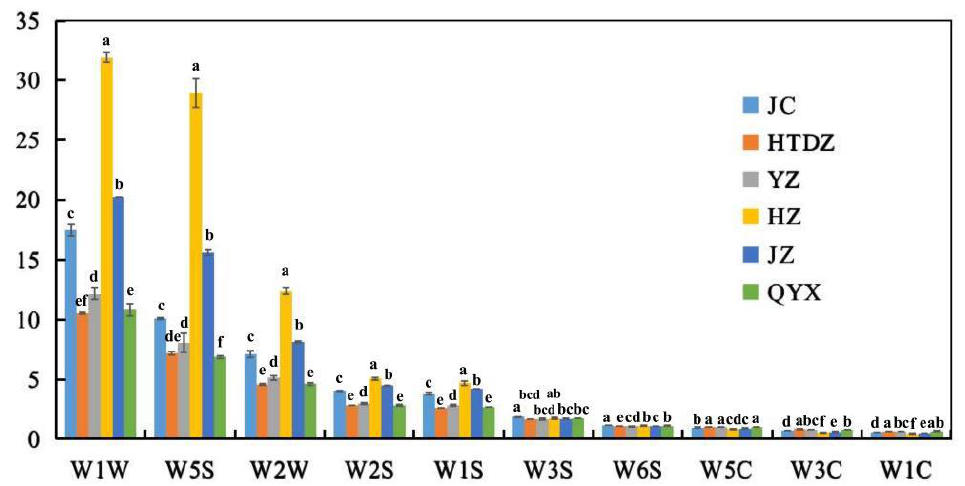
Figure 1. Figure 1. The response data of sensors in E-noses on volatiles of the six red jujube cultivars in Xin- vars in Xinjiang Province, China (Jinchang—‘JC’, Junzao—‘JZ’, Huizao—‘HZ’,Qiyuexian—‘QYX’, jiang Province, China (Jinchang —‘JC’, Junzao—‘JZ’, Huizao—‘HZ’,Qiyuexian—‘QYX’, Heti- Hetiandazao—‘HTDZ’, and Yuanzao—‘YZ’). Lower letters (a–f) correspond to significant differences andazao —‘HTDZ’, and Yuanzao—‘YZ’) . Lower letters (a – f) correspond to significant differences at p < 0.05. at p < 0.05.